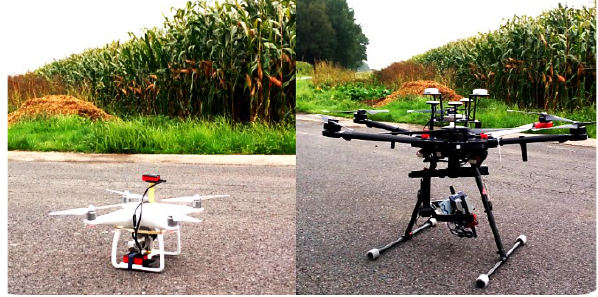
Figure 3. Showing sensors mounted on respective UAVs